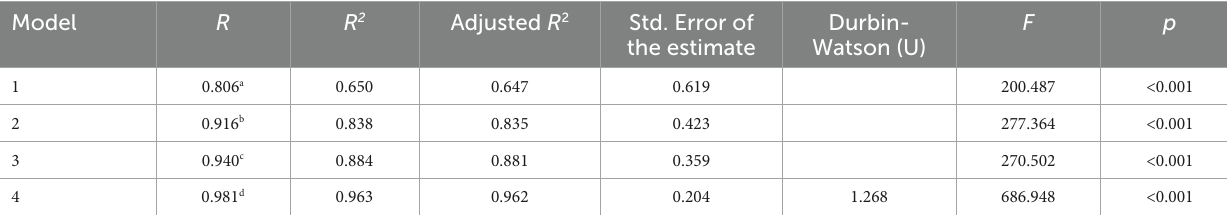
TABLE 1 Regression model summary. Model